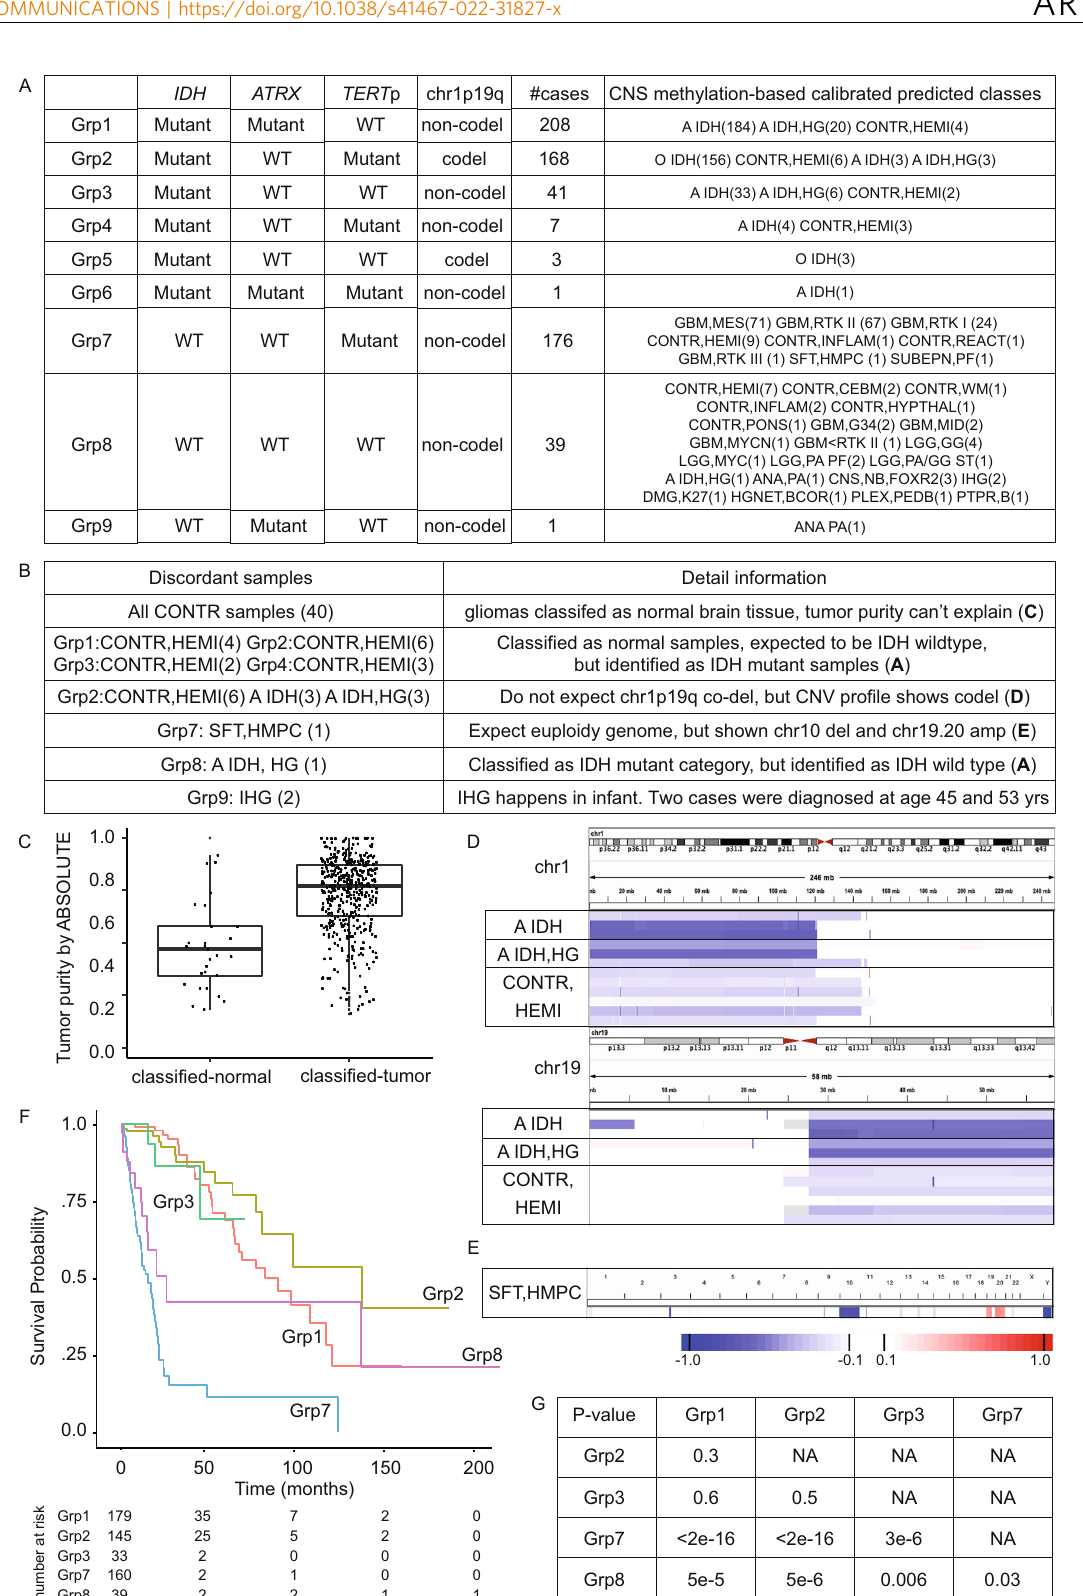
For validation, the fi nal model was applied to the test set and the external validation set (NOA-04) 17 . This trial compared the ef fi cacy and safety of radiotherapy followed by chemotherapy at progression to chemotherapy followed by radiotherapy at progression in patients with anaplastic gliomas ( n = 115). DNA methylation HM450K data were available for all tumor samples. Most of the tumors were characterized for genomic alterations and these data served as the reference standard for comparison: targeted resequencing of the ampli fi ed